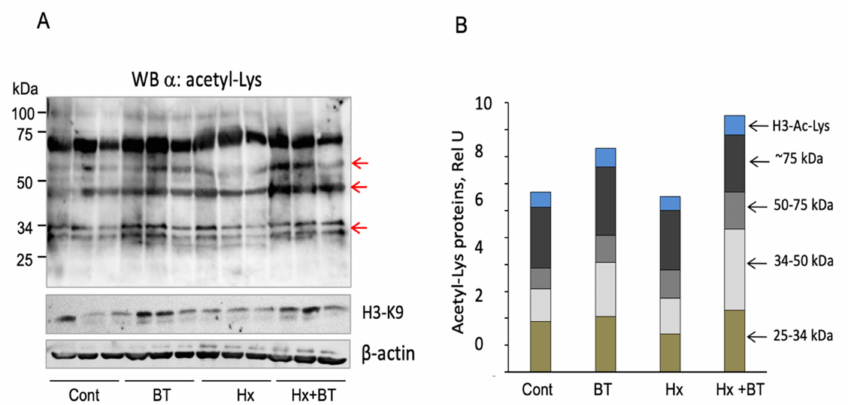
Figure 6. Butyrate increases protein acetylation in the lungs. ( A ): Total lung extracts (30 µ g) obtained from each individual animal were analyzed by Western blot with anti-Ac-Lys and anti-Ac-H-Lys (K9) antibodies. Arrows indicate proteins that showed increased acetylation levels and H3-Ac- Lys; ( B ): Quantitative analysis of protein acetylation. Arrows indicate protein ranges (25–34 kDa, 34–50 kDa, 50–75 kDa, and ≈ 75 kDa) used for quantitative analysis; shown are data from three independent